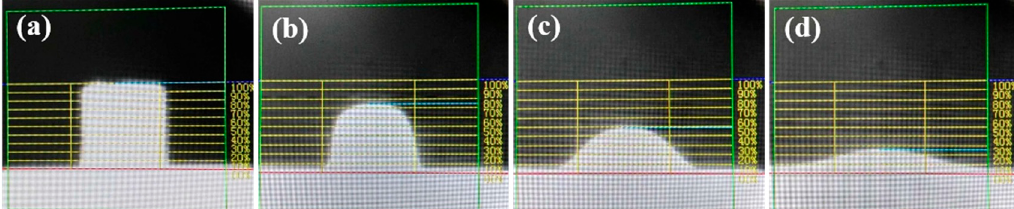
Figure 1. Diagram of the LZ-III slag melting temperature characteristic tester.